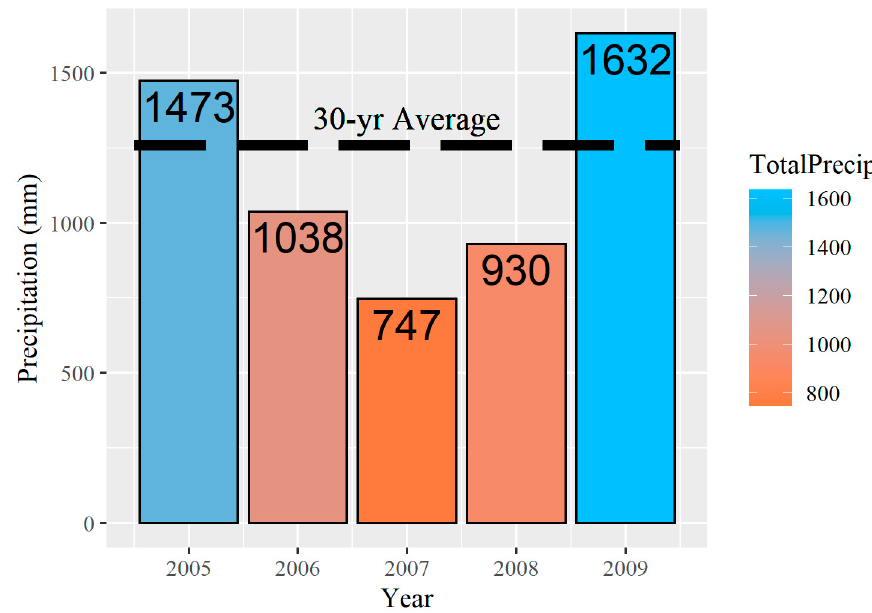
Figure 2. Annual precipitation for Watkinsville, Georgia from the National Resource Conservation Service (NRCS) Soil Climate Analysis Network (SCAN) dataset [27]. The dashed line represents the long-term average precipitation value (30-yr; 1980 –